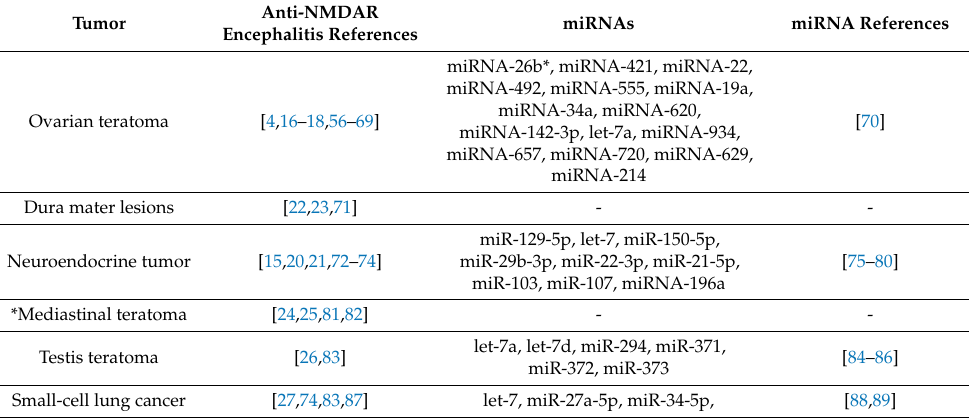
Table 1. Tumors associated with anti-NMDAR